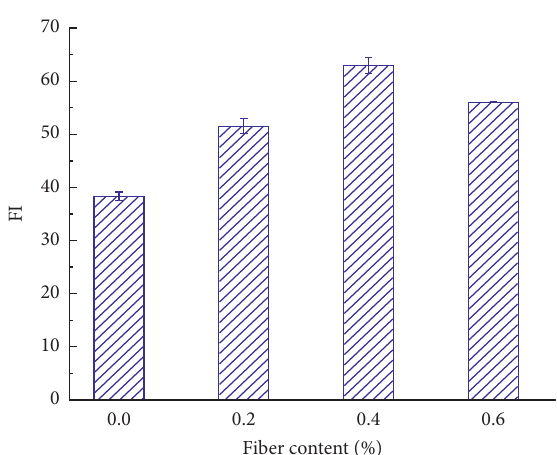
Figure 11: FI versus fiber